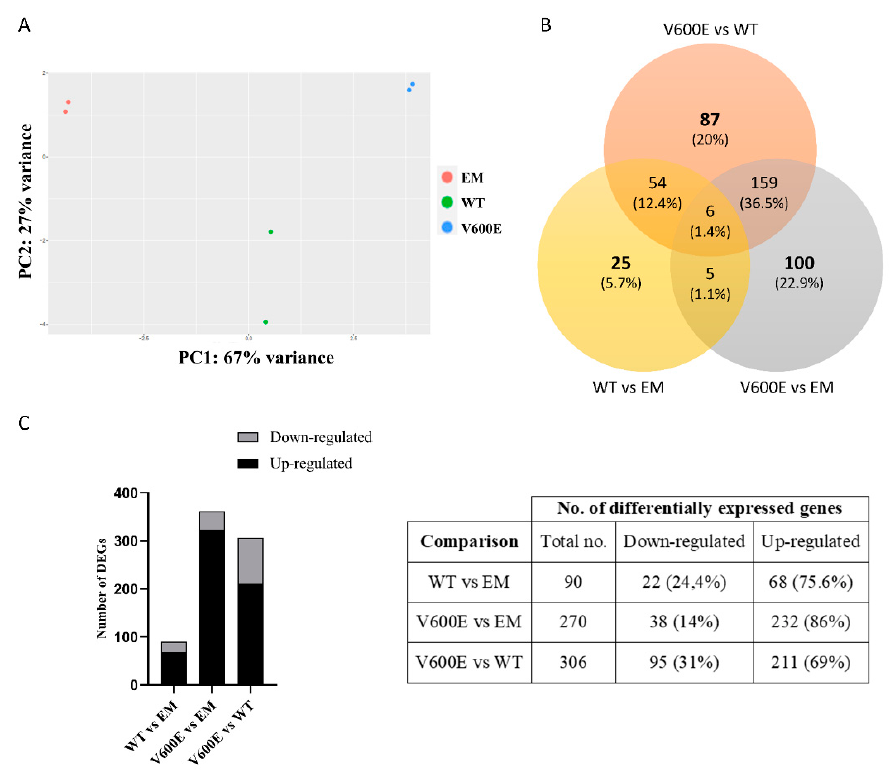
Figure 6. Principal component analysis (PCA) plot and the number of DEGs obtained from BGI RNA-Seq (transcriptome) sequencing. ( A ) The clustering of color-coded dots indicates high consistency between replicate samples. Dots refer to RNA samples extracted from (1) THLE-2 cells transfected with empty plasmid (EM) are marked in red, (2) BRAF WT-transfected THLE-2 cells (WT) are presented as green, (3) BRAF V600E-transfected THLE-2 cells (V600E) are marked in blue. ( B ) Venn diagram of DEGs. Three comparisons were analyzed, as follows: WT vs. EM, V600E vs. EM, V600E vs. WT. The overlapping part of the different circles indicates the number of DEGs com- mon to respective groups. ( C ) The results indicated down-regulated and up-regulated genes in com- parisons, as follows: WT vs. EM, V600E vs. EM, and V600E vs. WT. A p -value cut-off of 0.1 after Benjamini–Hochberg multiple-testing correction was used to fulfill the criteria of significance. Transcriptome analysis data revealed 436 significantly differentially expressed genes (DEGs) from all experimental variants. The score of 25 genes (5.7%) in WT vs. EM, 100 genes (22.9%) in V600E vs. EM, and 87 genes (20%) in V600E vs. WT comparisons were differentially expressed and unshared between other groups. The number of down-regu- lated or up-regulated genes distributed among the study groups are presented in the Venn diagram (Figure 6B). The obtained data indicated DEGs in three analyzed comparisons, as follows: 90 significantly DEGs in WT vs. EM (22 down-regulated and 68 up-regulated), 270 DEGs in V600E vs. EM (38 down-regulated and 232 up-regulated), and 306 DEGs in V600E vs. WT (95 down-regulated and 211 up-regulated) (Figure 6C). Moreover, DEGs were presented as a heatmap based on hierarchical clustering analysis (Figure 7). The col- umns represent WT vs. EM, V600E vs. EM, V600E vs. WT comparisons, where each row represent a gene. The most up- and down-regulated genes are presented in Table 2.